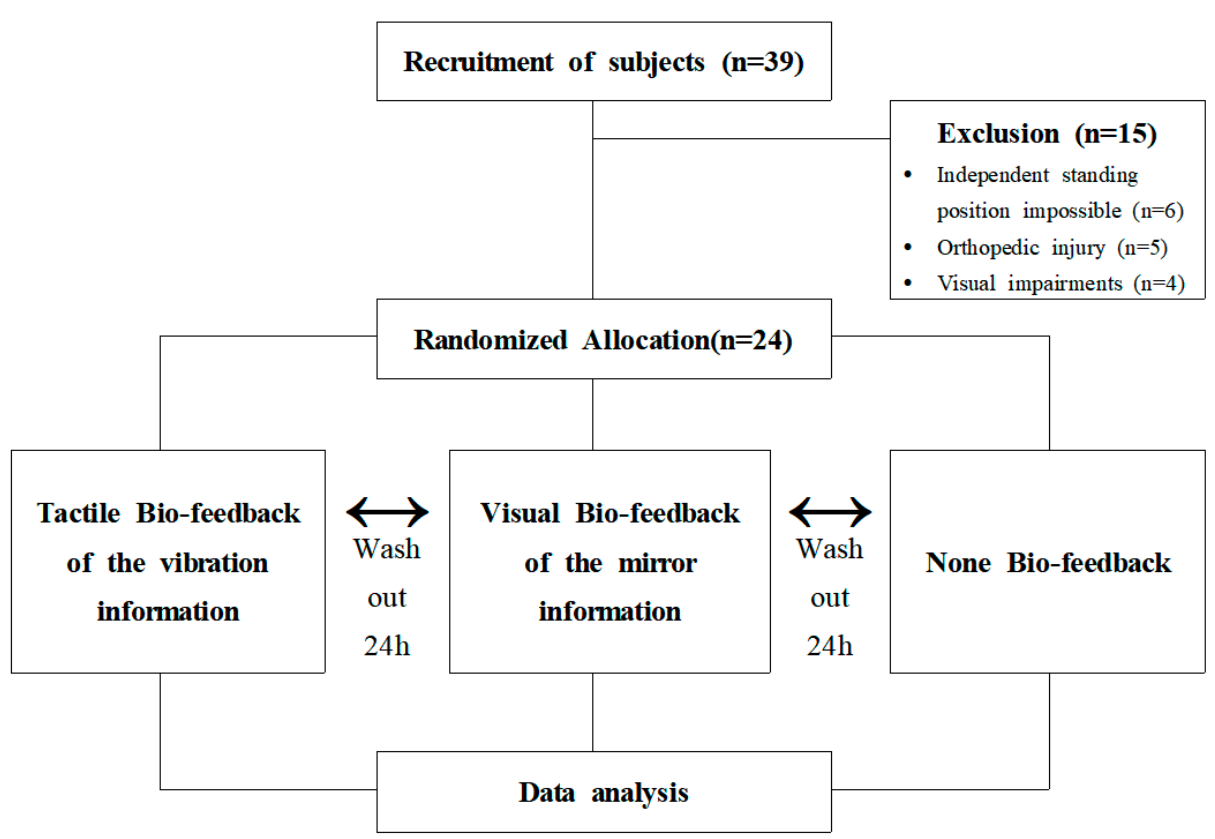
Figure 1. Flow chart.